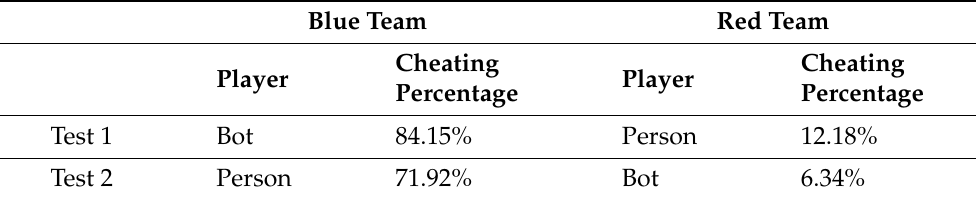
Table 2. Result of 1v1